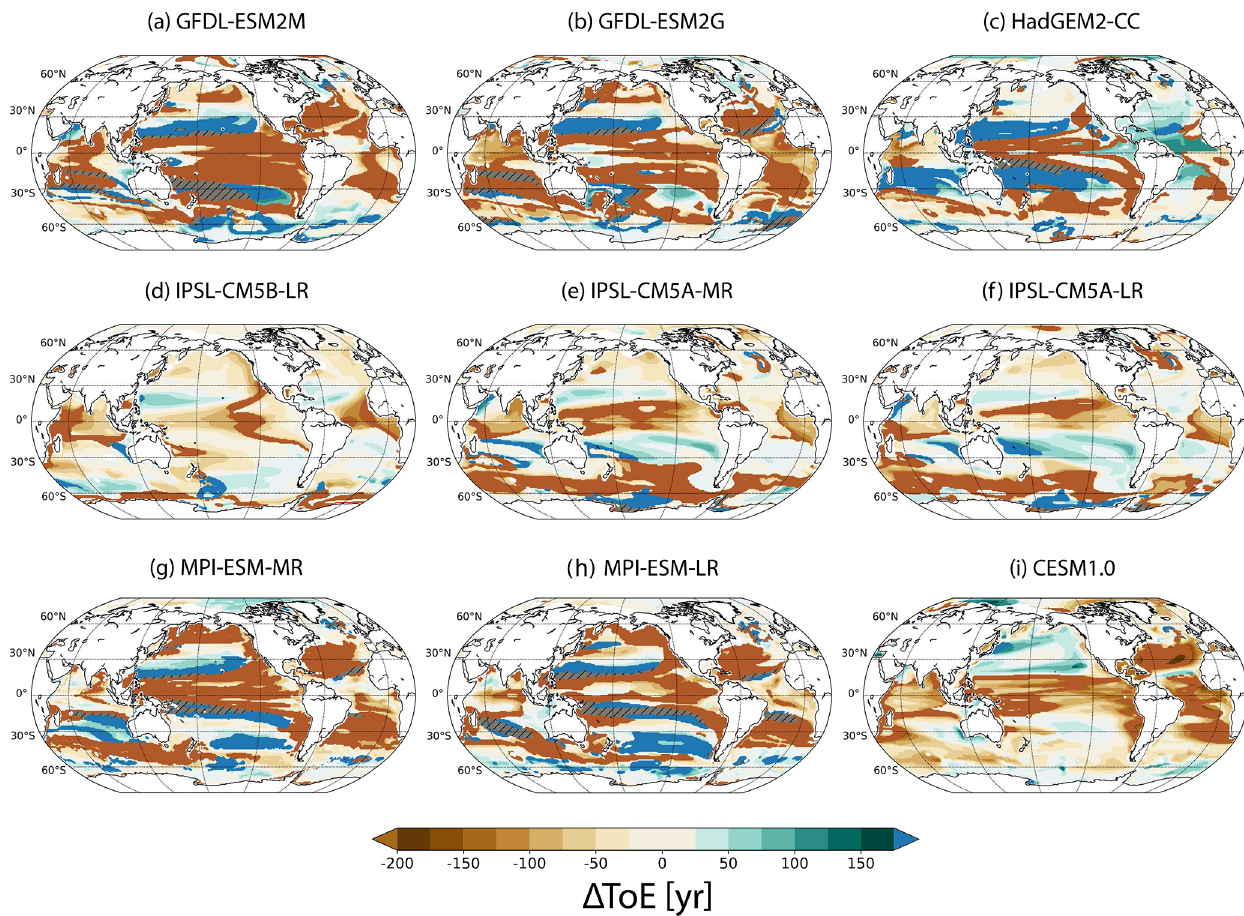
Figure 6. (cid:49) ToE defined as ToE( T ) minus ToE(O 2 ) for each simulation in the thermocline. Blueish colours indicate earlier emergence of oxygen. Brownish colours indicate earlier emergence of temperature. The saturated colours mean that one of the variables has not emerged by 2099. No emergence in both T and O 2 is shown by the hatched areas.